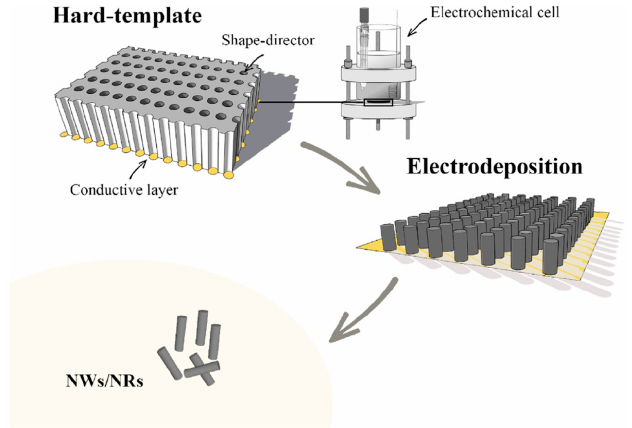
Figure 3. Schematic representation of NRs/NWs electrosynthesis using the hard-template approach. First, the hard template in which the nanochannels (shape director) are observed, equipped with a conductive layer in one of the two sides, is used as a working electrode in the electrodeposition process in a three-electrode cell. After electrodeposition the hard-template and/or conductive layer can be removed to obtain free-standing NRs/NWs. Image reproduced from [24] with permission.